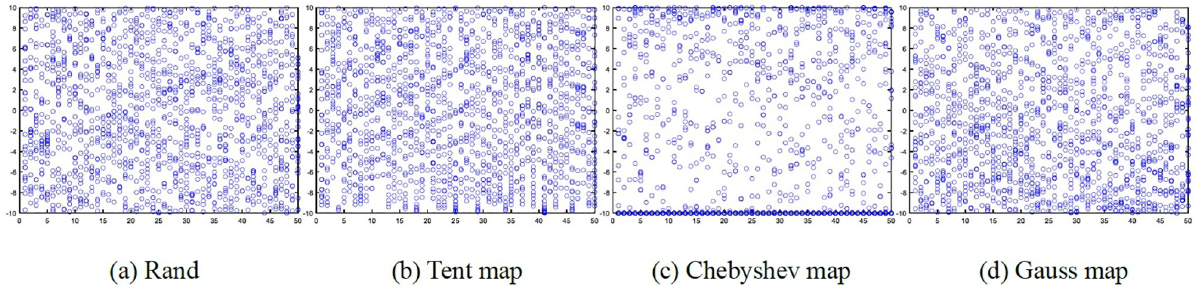
Fig 1. Initial population generated by 3 kinds of maps in 1000 iterations. (a) Rand, (b) Tent map, (c) Chebyshev map, (d) Gauss map.